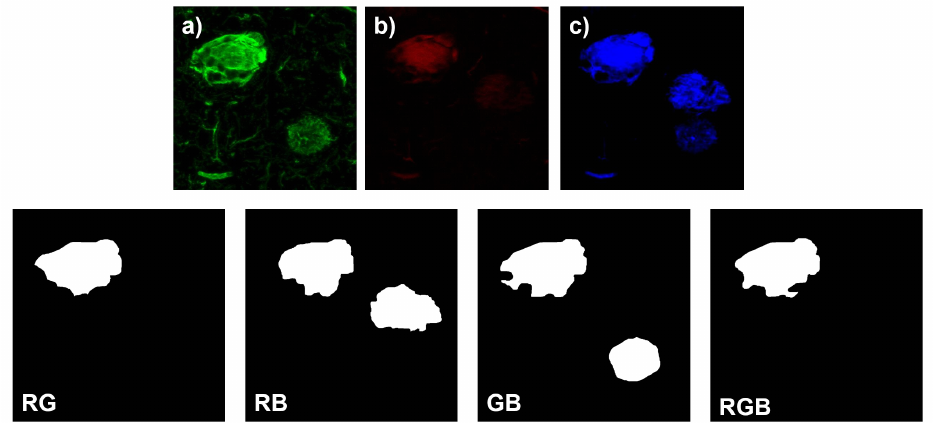
Figure 2. Representative images of an immunofluorescence assay with double immunostaining and thiazine red dye staining of the hippocampus of an AD patient and examples of assignment of the corresponding training labels. ( a ) Immunoreactivity of AT8 antibody (green channel) detect- ing pathological phosphorylations at amino acids serine 202 and threonine 205 of the tau protein is observed. ( b ) Positive staining against fibrillar forms of tau protein is observed in the red channel. ( c ) The 396 antibody (blue channel) detects pathological phosphorylation at serine 396 of the tau protein. The images at the bottom are the training labels. The labels show the specific channel combination that they are targeting. R: red; G: green; B: